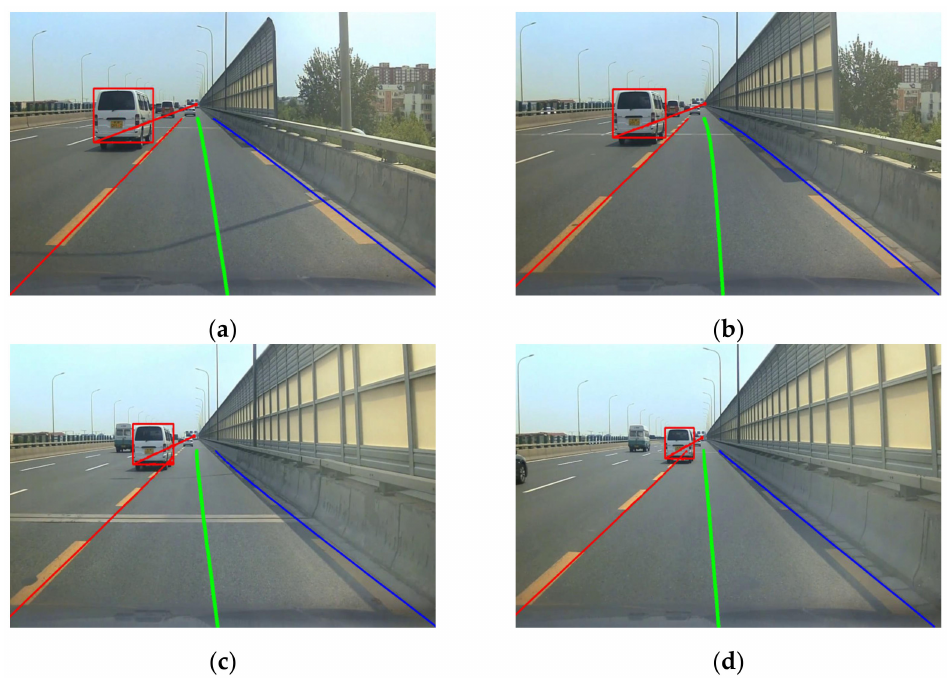
Figure 20. Target vehicle angle α changing with the target vehicle lane-changing. ( a ) First frame. ( b ) Third frame. ( c ) Fifth frame. ( d ) Seventh